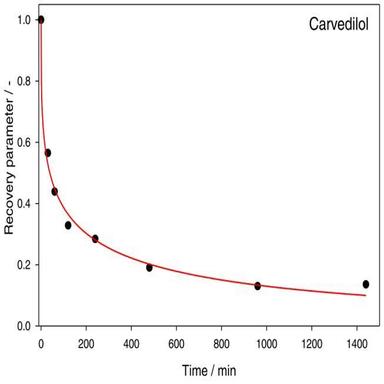
Recovery parameter for amorphous carvedilol aged at 303.15 K (30 ◦C) as a function of ageing time. The solid line represents the fit of the experimental data to the Kohlrausch–Williams–Watts (KWW) function (Eq. 11).